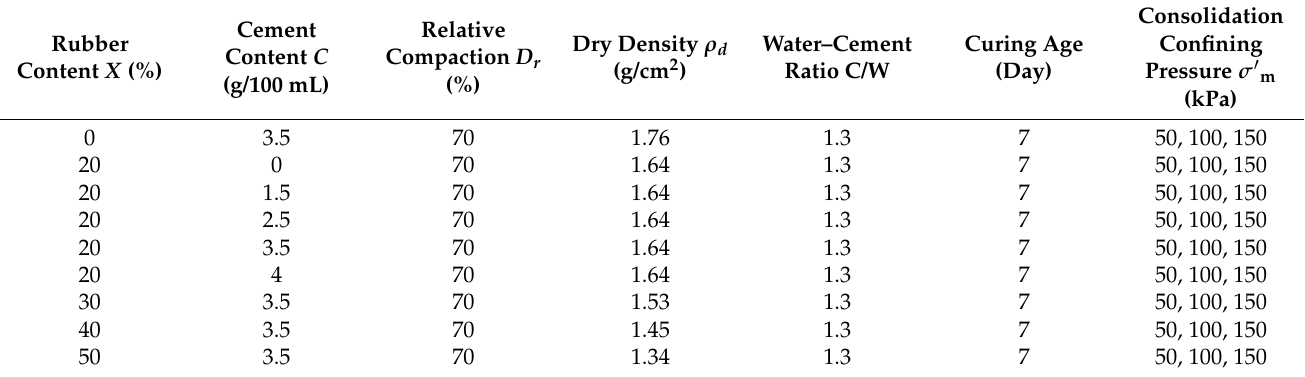
Table 2. Test conditions of the RCS soil.